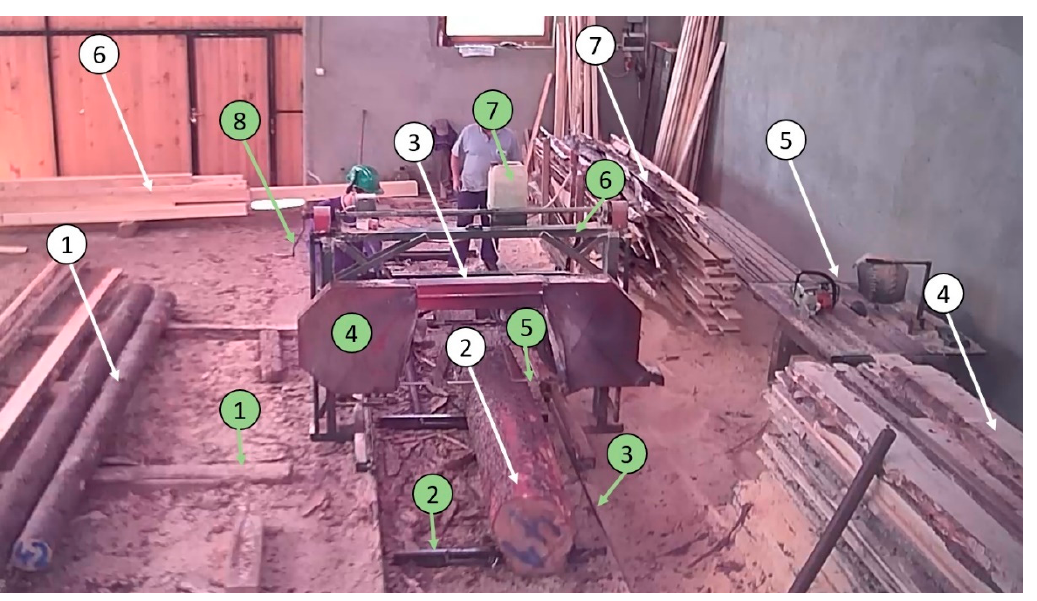
Figure 1. Description of wood processing facility. Legend: in white: 1 —log feedstock, 2 —processed log, 3 —machine (bandsaw), 4 —processed planks, 5 —regular circular saw, 6—processed products, 7 —residues; in green: 1—transversal wooden strut, 2 —fixing traverse, 3 —rolling rail, 4 —metallic cover, 5 —blade, 6 —frame, 7 —water tank, 8 —lever.